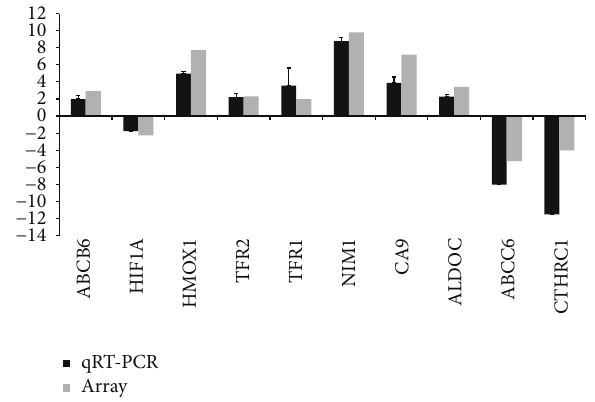
Figure 4: Comparison of gene expression changes from microarray and qRT-PCR